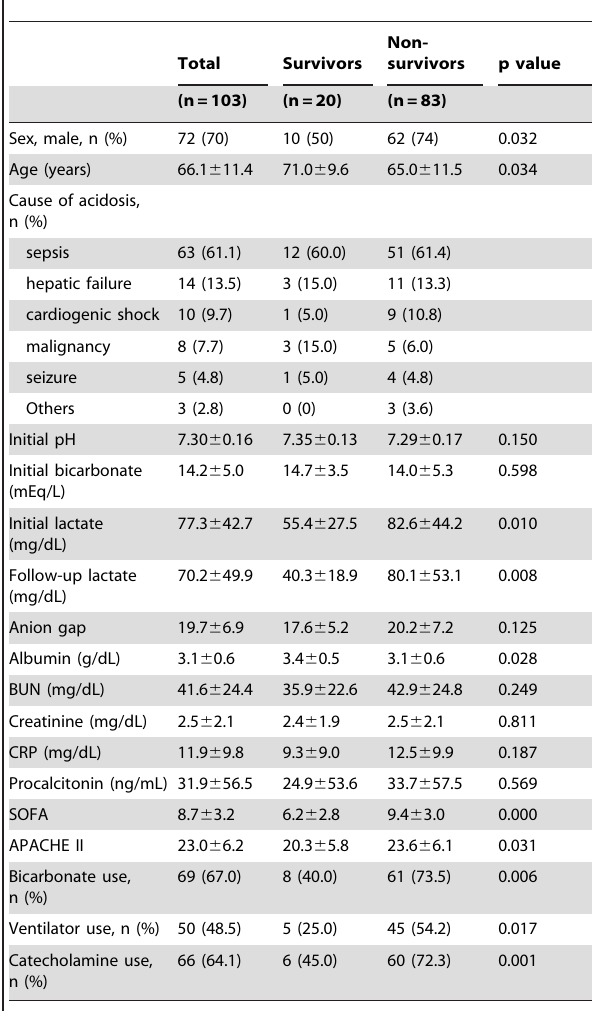
Table 1. Patient characteristics according to